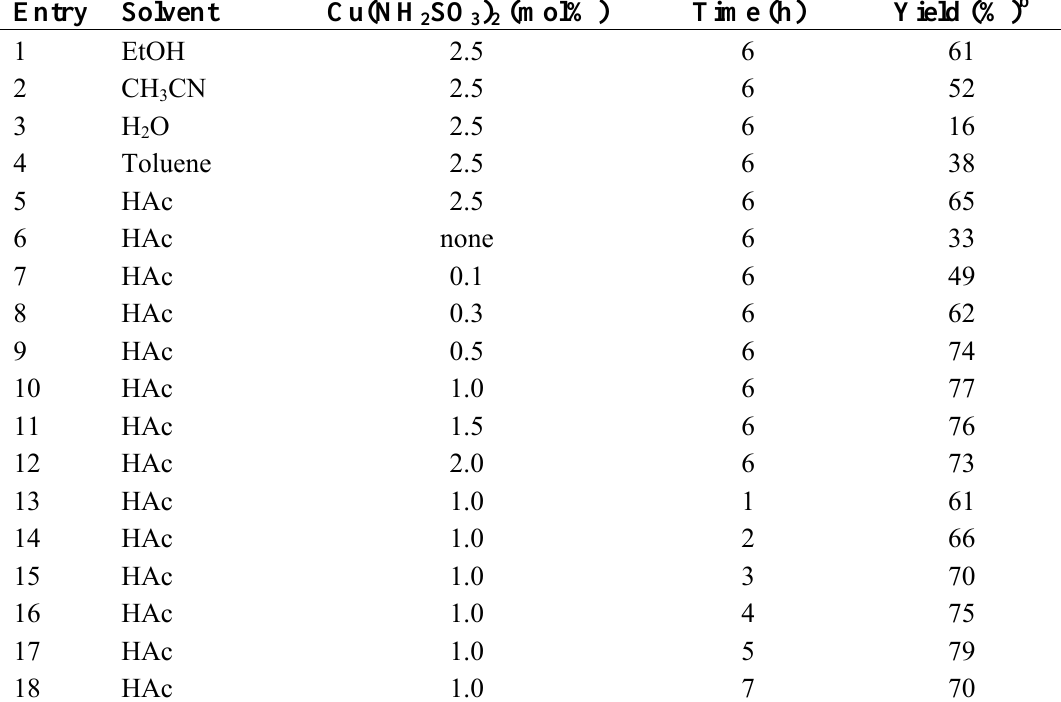
Table 1. Effect of catalyst Cu(NH condensation of benzaldehyde, ethyl acetoacetate and urea a